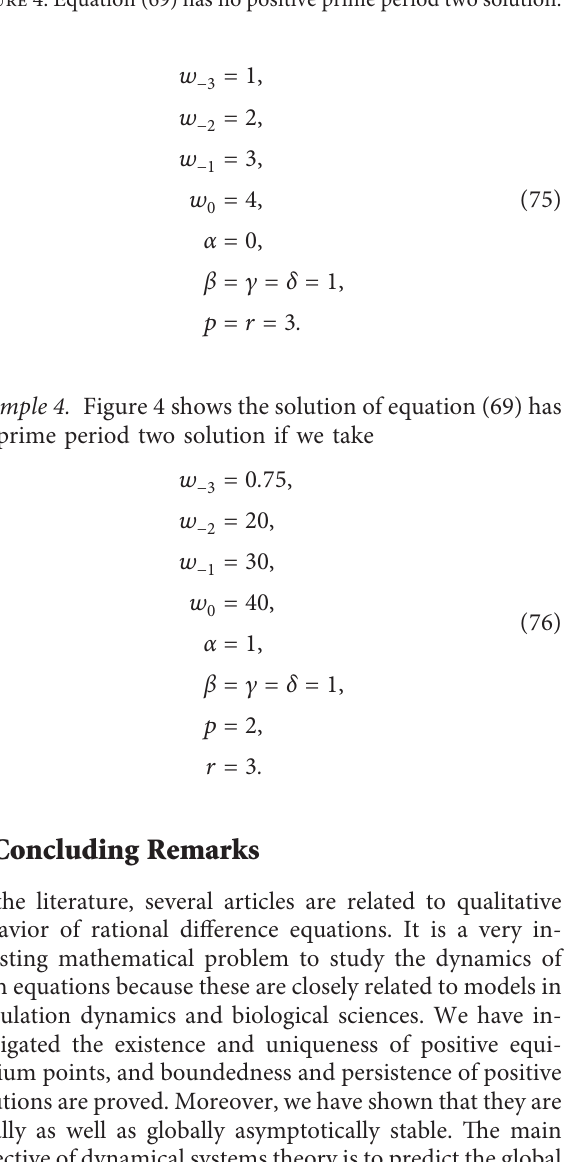
Figure 4: Equation (69) has no positive prime period two solution. Figure 1: Bounded solution of equation (56).